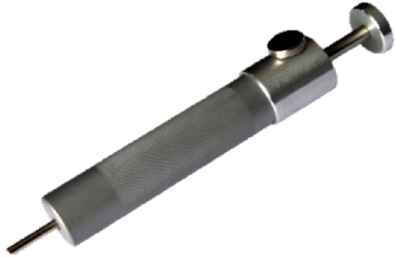
Figure 1. ‘The Ballista’: a penetrative spring-powered captive bolt (CB) gun used for the euthanasia of guinea pigs in this research. Image used with permission [51]